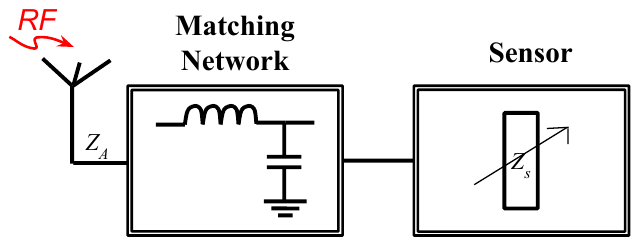
Figure 5. Block diagram of a chip-less RFID-based wireless sensor.